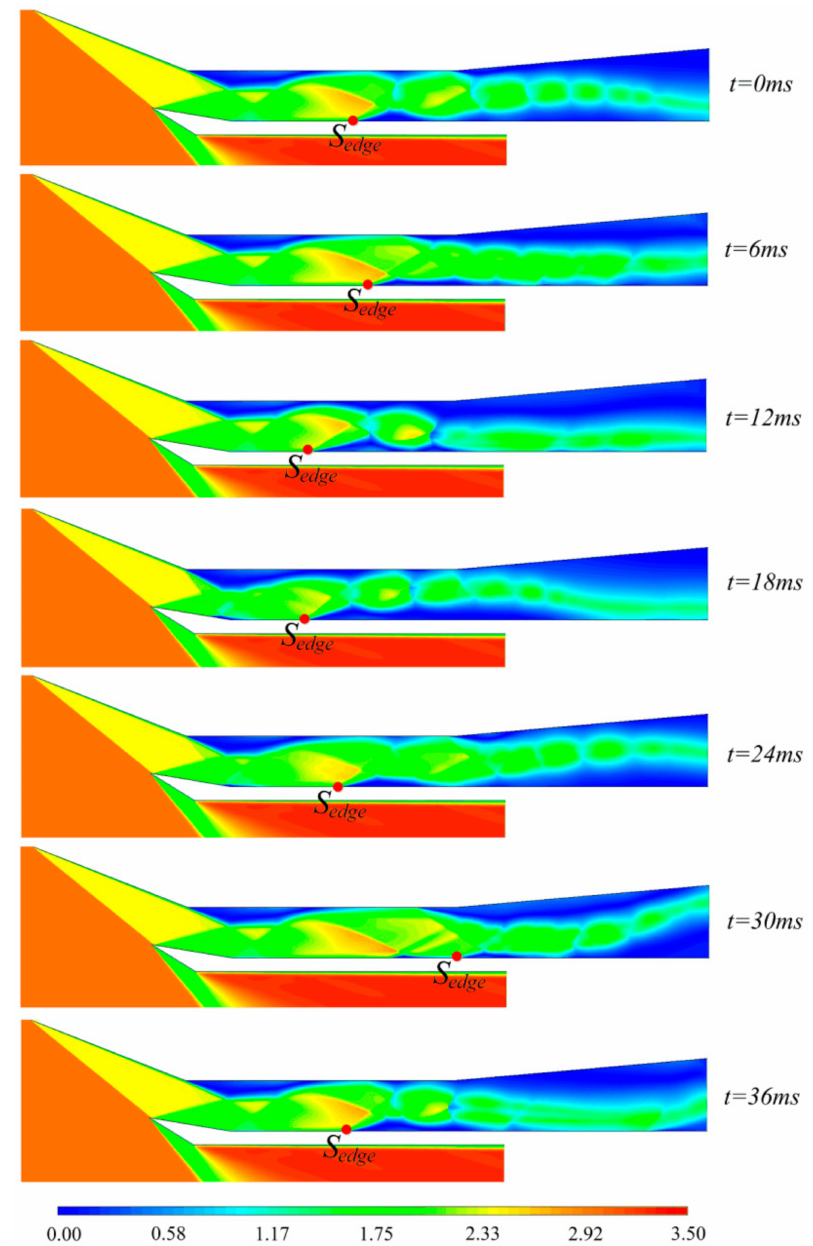
Figure 16. Mach number contour change process of Model A.